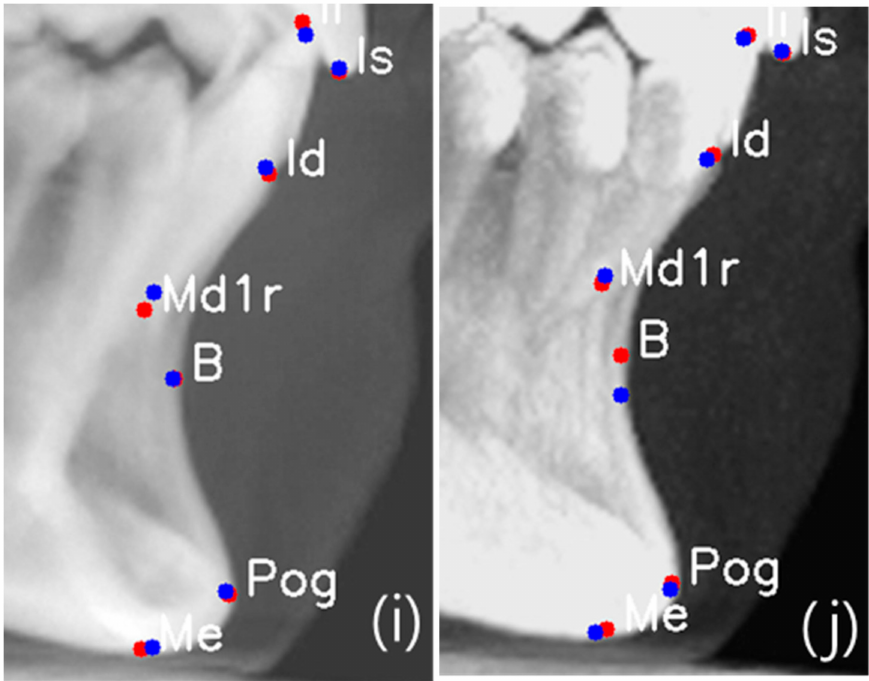
Figure 5. Comparison of AI prediction between CBCT-LC ( a , c , e , g , i ) and MIP-LC ( b , d , f , h , j ); Orbitale c and d ; Maxilla e and f ; Porion g and h ; and Mandible i and j . The red dot is manual identification (truth ground), and the blue dot is AI